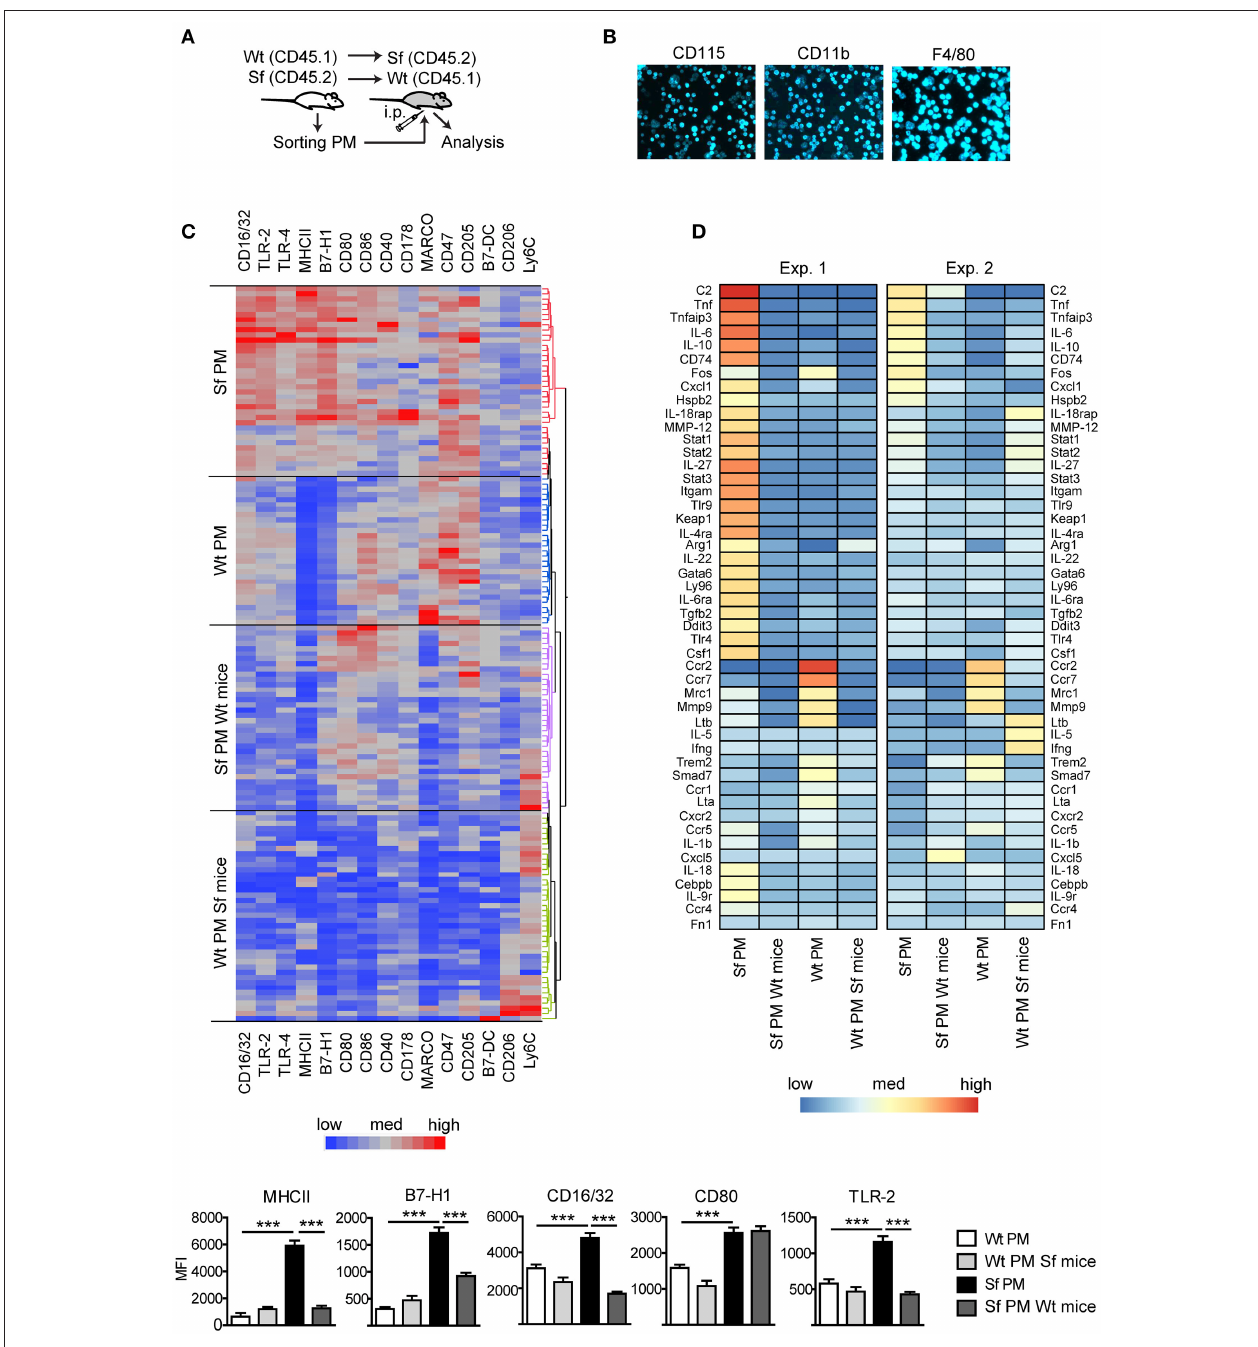
FIGURE 3 | Immunophenotyping by single-cell chipcytometry and transcriptomics reveal plasticity of peritoneal macrophage activation profiles . (A) Schematic outline of the experimental protocol, (B) exemplary surface marker stainings of the cells fixed on chip, and (C) immunophenotyping of scurfy (Sf) and unaffected (Wt) peritoneal macrophages (PM) from the untreated mice and after their transfer to Wt or Sf peritoneal cavity (“Sf PM Wt mice” and “Wt PM Sf mice”), respectively, performed by single-cell chipcytometry. Data are depicted as mean fluorescent intensities (MFI) for each surface marker expressed by single cells and shown as heatmaps (middle) and bar graphs (bottom; n ∼ 60 cells per group, pooled from more than 8 donor mice). (D) Microarray-based transcriptome analysis of gene expression in PM from untreated Sf and Wt mice and after their intraperitoneal (i.p.) transfer to Wt or Sf mice, respectively (“Sf PM Wt mice” and “Wt PM Sf mice”; two independent experiments, each experimental group contains pooled cells from more than 5 mice). Statistical analysis was performed using one-way ANOVA, *** p < 0.001.